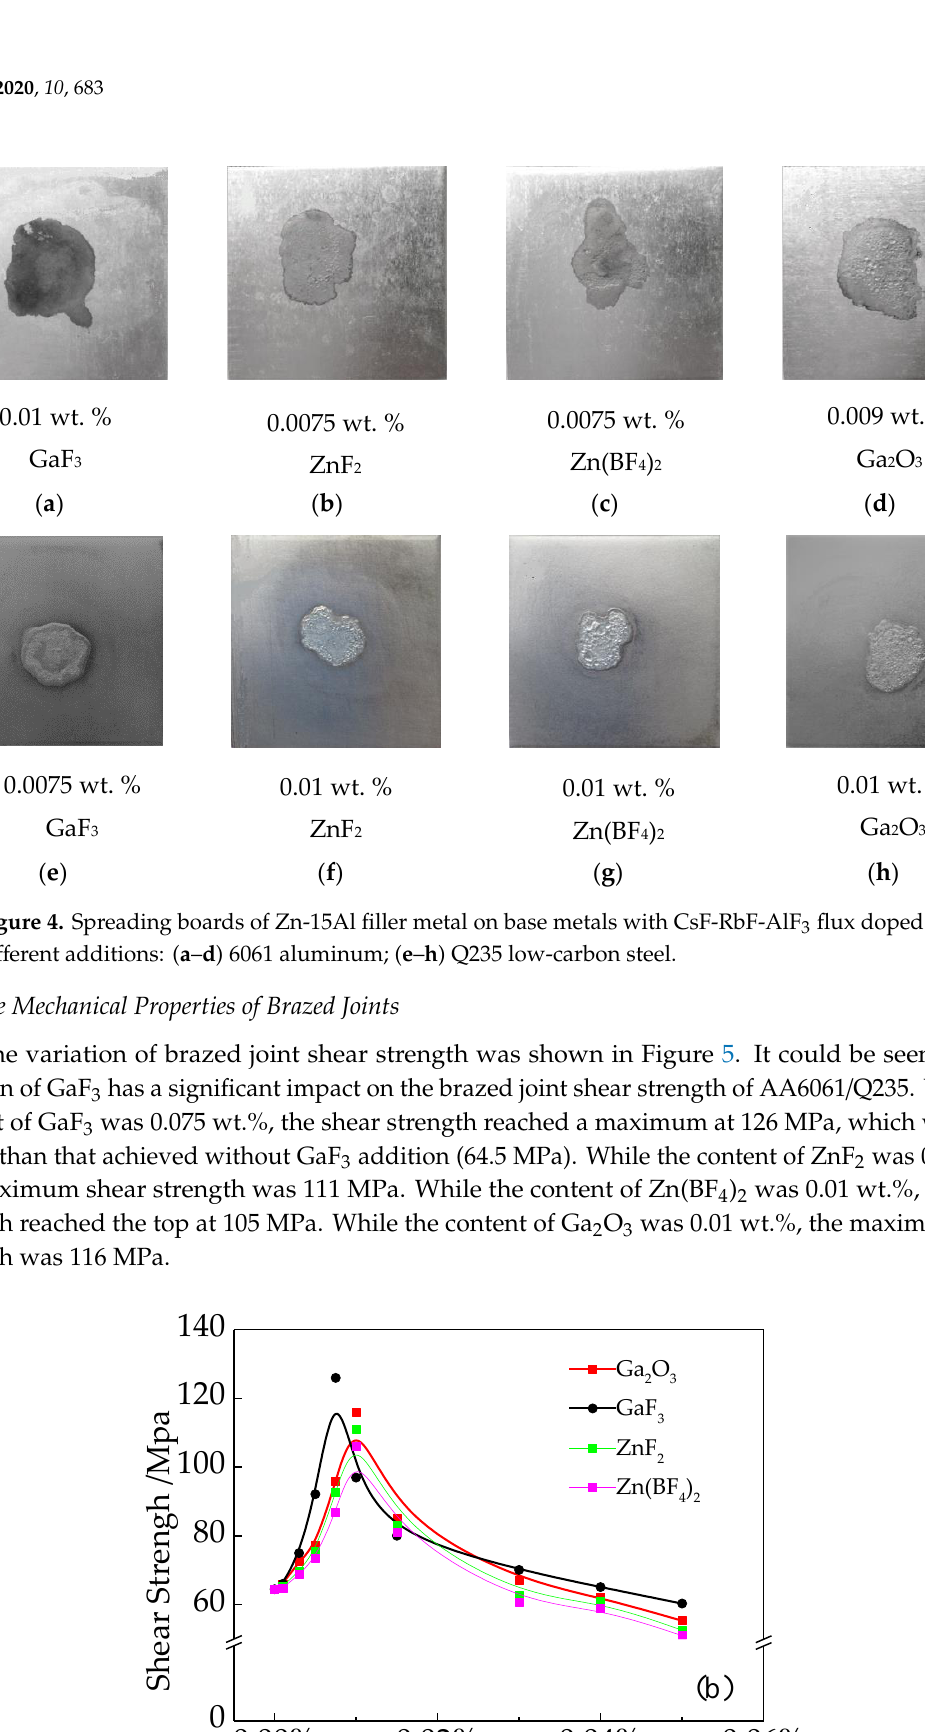
Figure 3. Spreading areas of Zn-15Al filler metal ( a ) 6061 aluminum alloy; ( b ) Q235 steel.